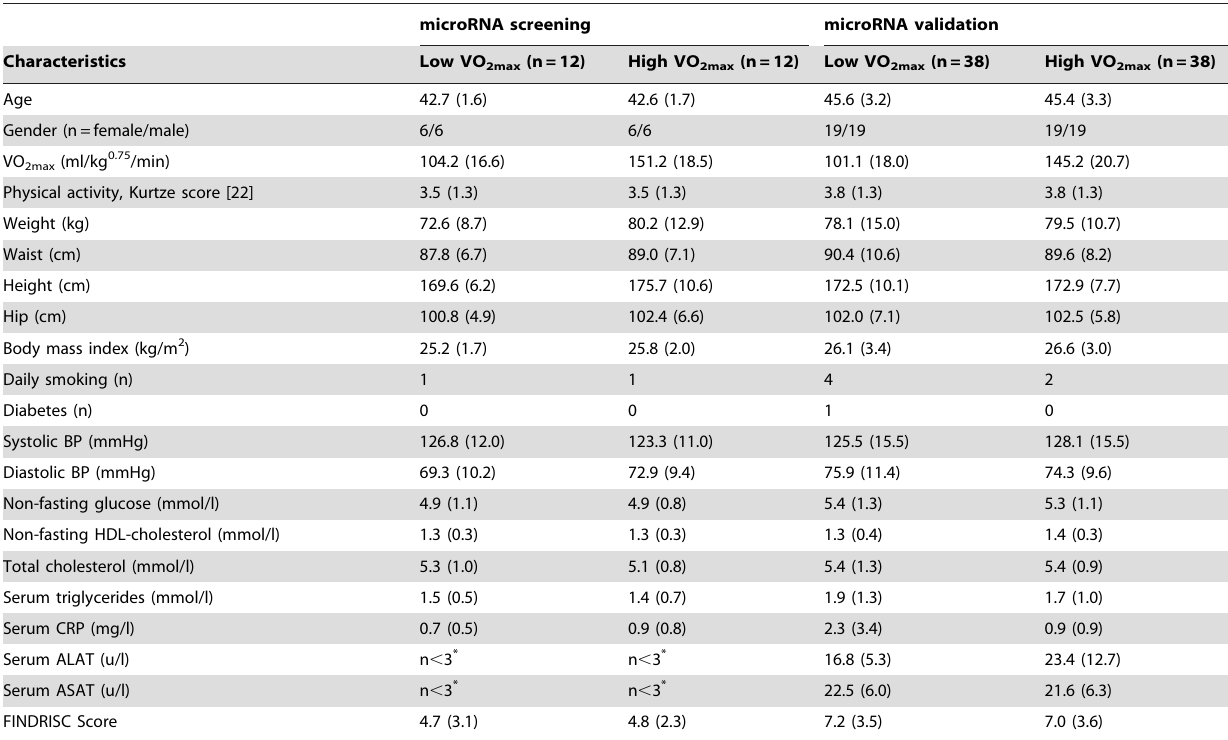
Table 1. Baseline characteristics of the study